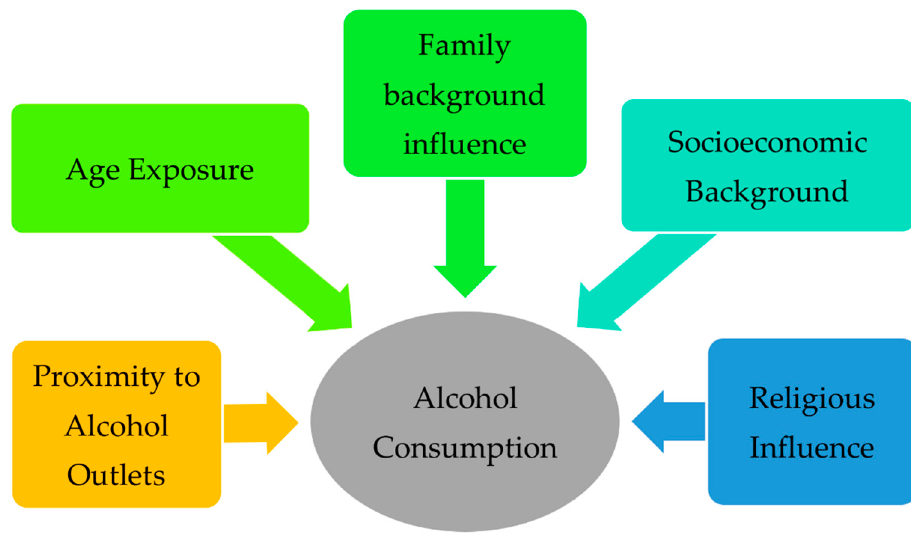
Figure 2. Factors associated with alcohol consumption